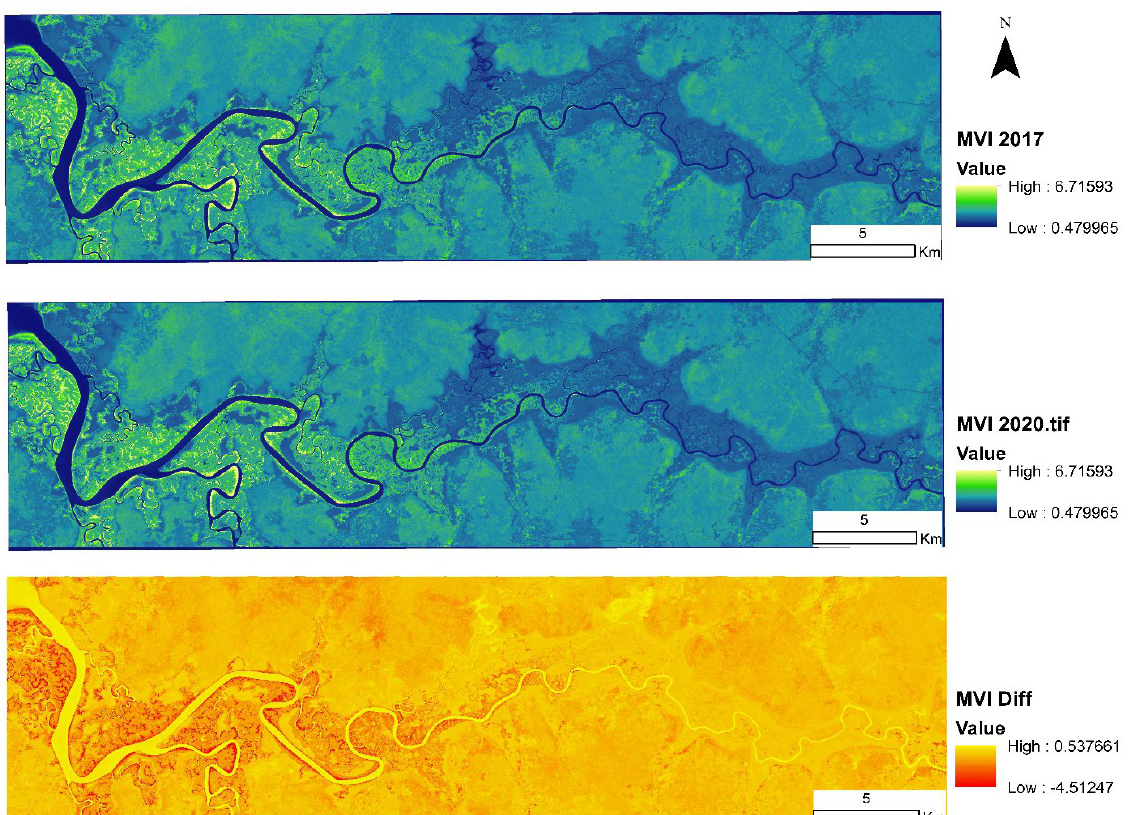
Figure 4 . Mangrove vegetation index – MVI 2017 (top), MVI 2020 (middle) and MVI Difference